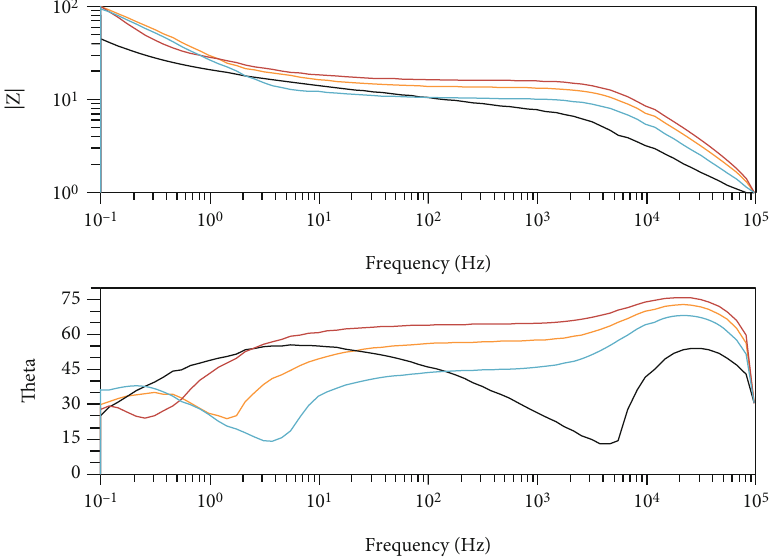
Figure 15: Bode diagram of carbon steel electrode in 3.5% NaCl solution with di ff erent concentrations of thiourea-modi fi ed polyepoxysuccinic acid (CNS-PESA).